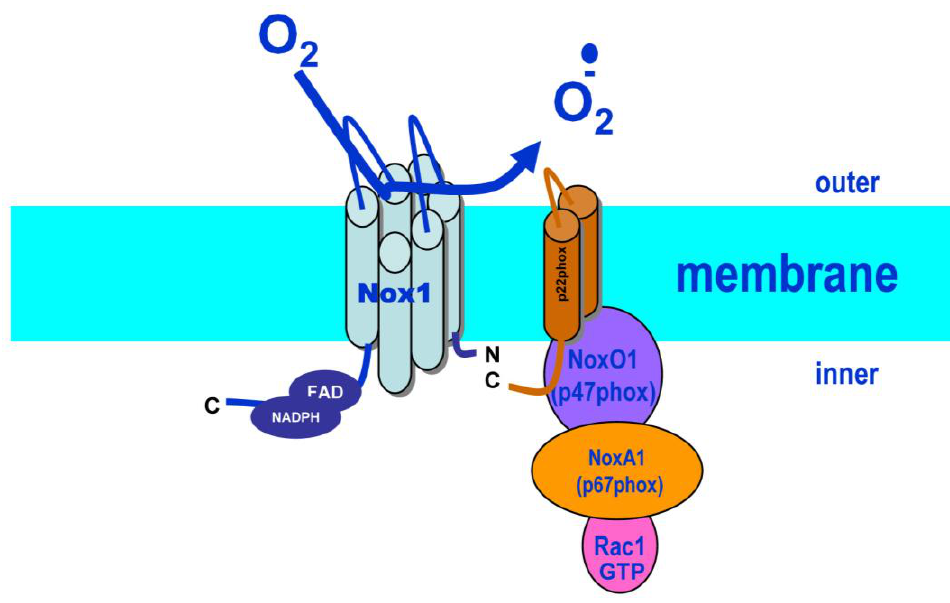
FIGURE 1 . Nox1 and its regulatory subunits NoxO1, NoxA1, and Rac1, as well as the assembly factor p22 phox